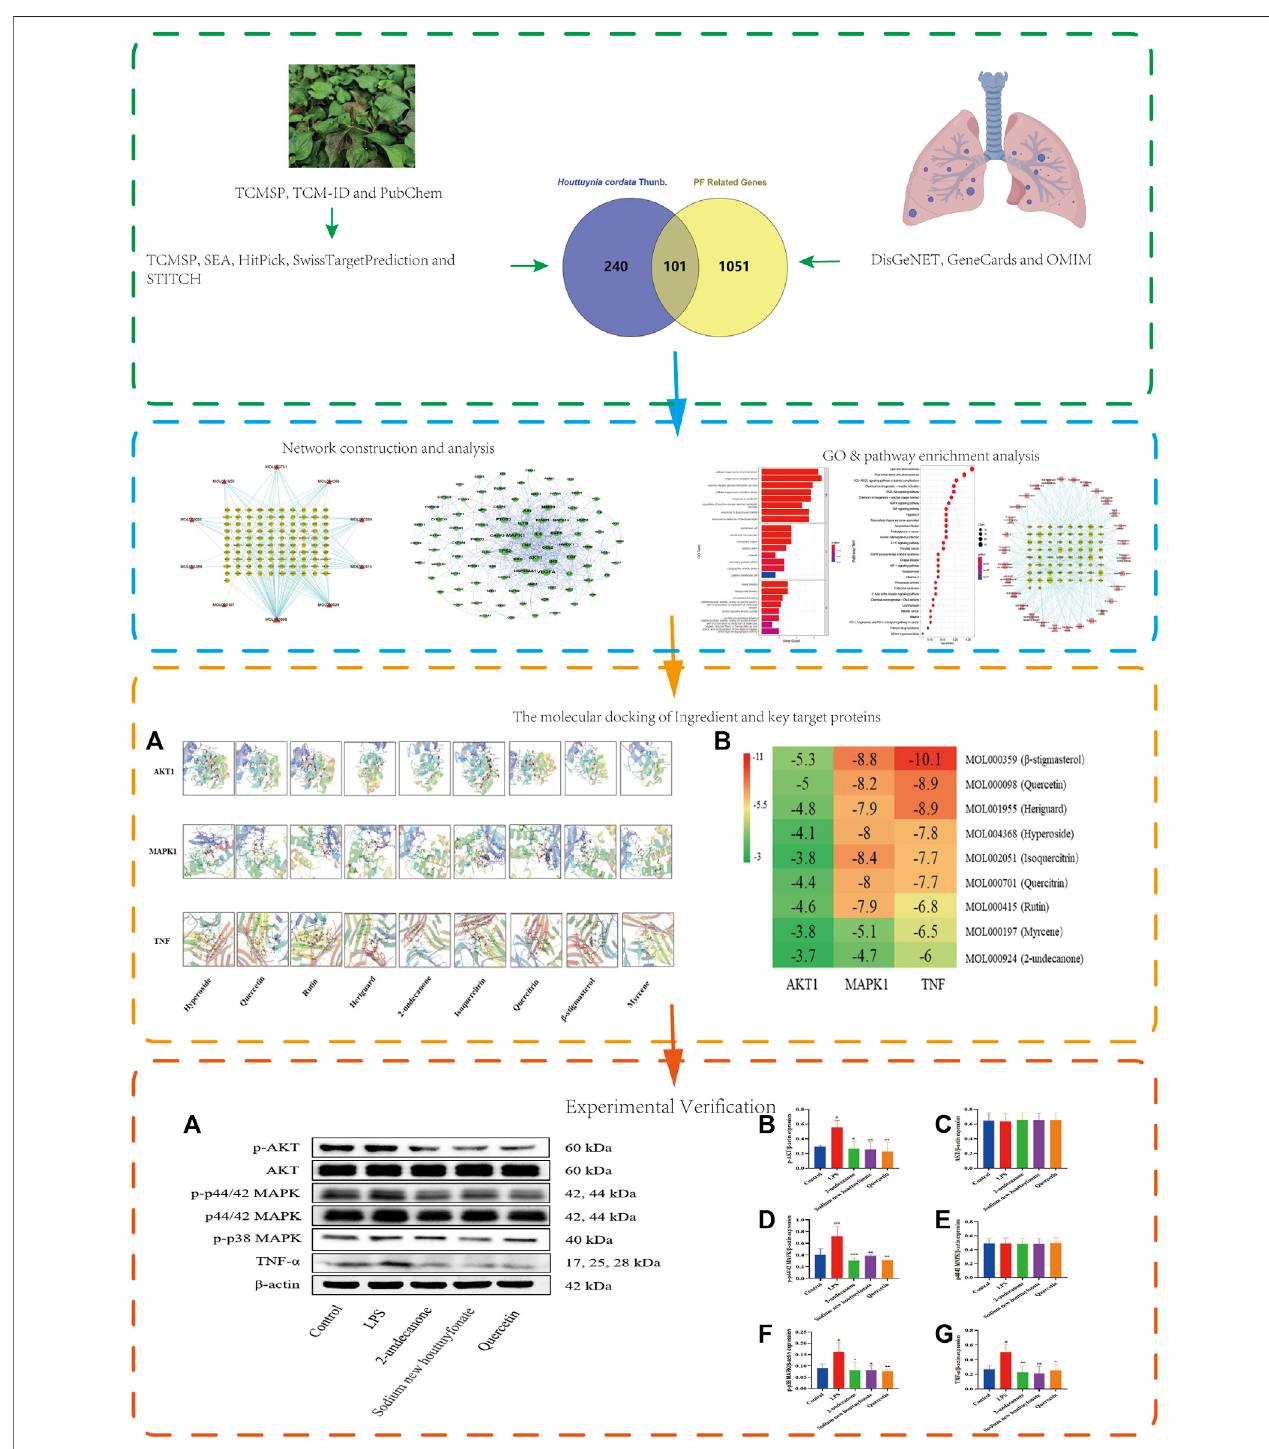
FIGURE 1 | Flowchart of network pharmacology research on the mechanism of H. cordata in anti-pulmonary fi brosis.